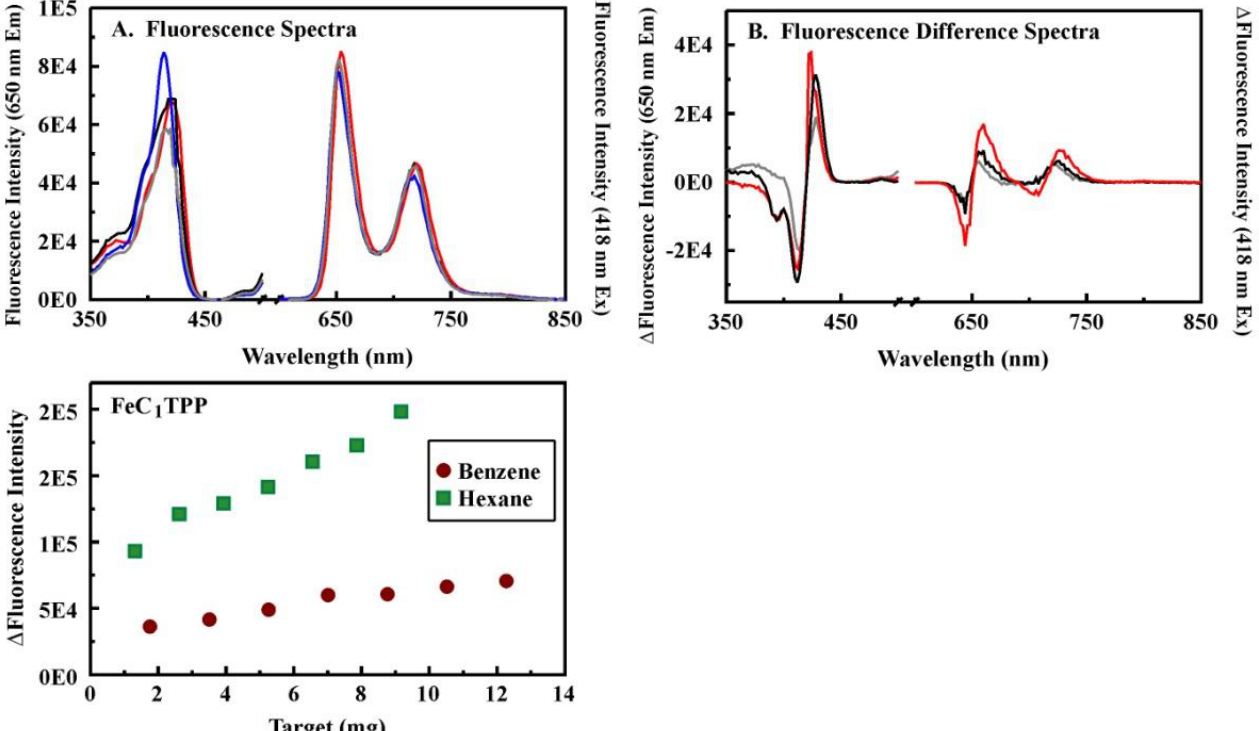
Figure 6. Interaction of targets with FeC TPP-embedded B100. Panel A, fluorescence 1 excitation and emission spectra for the FeC TPP-embedded B100 material (2 mg) in the 1 absence (blue) and presence of 3.5 mg (gray), 5.3 mg (black), and 12 mg (red) benzene. Panel B, difference fluorescence spectra for exposure of the material to benzene. Panel C, binding isotherms for the interaction of FeC TPP-embedded B100 with benzene (425 and 1 414 nm) and hexanes (417 and 415 nm) based on the peak/trough difference in intensity. Results for additional metalloporphyrins are provided in Supporting Information, Figures S4 through